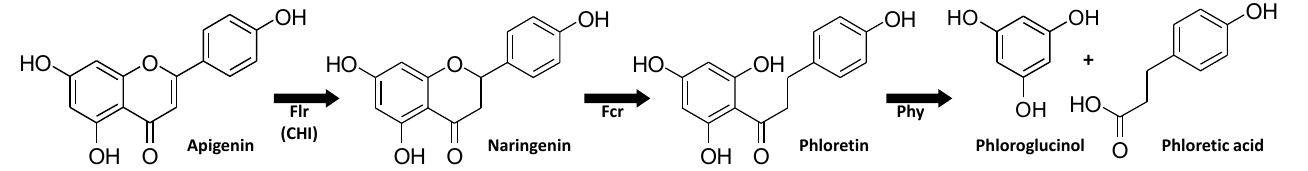
Figure 6. Reductive degradation of flavonoids depictured with apigenin as a flavone example. The BLAST analysis with the characterized flavanone- and flavanonol-cleaving reduc- The very recently characterized Flrs from Flavonifractor plautii and Clostridium ljung- tase (Fcr) from Eubacterium ramulus resulted in hits identified in F. plautii MAGs (523 overall dahlii [50] resulted in a large number of hits in F. plautii and Clostridoides difficile MAGs occurrences, Supplementary Excel File), while E. ramulus MAGs revealed a lower number (the latter interestingly with a higher PID to the sequence of F. plautii than to the sequence of 188 occurrences. Similar to the situation with Flr, several E. ramulus genomes contained of C. ljungdahlii ), and, with a lower PID, in MAGs of the Olsenella, Eubacterium and Fuso- two fcr genes, one of which had a higher PID to the F. plautii gene, which might reflect a bacterium species (Figure 7). Most of the F. plautii MAGs (and also the strain type DSM different substrate spectrum of the encoded Fcrs. Besides F. plautii and E. ramulus , MAGs 6740) harbor two copies of the flr gene, with one of them more closely related (PID of ~ 60) assigned to Anaerostipes hadrus frequently (138 MAGs) encoded an Fcr-like enzyme with to that of Clostridium ljungdahlii than to the “main” Flr of F. plautii . This second putative approximately 85% identity to Fcr from E. ramulus . Besides these three main species, a Flr of F. plautii did not show any apigenin-reducing activity [50], but might reduce other number of MAGs from Clostridium boltae encoded a putative Fcr with a PID of approxi- flavonoid classes, which were not tested in the corresponding study. mately 42 to the Fcr from F. plautii . Most hits to Fcr (several hundred up to nearly 1000) showed around 35 PID (Figure 8) and frequently occurred, in particular, in Faecalicatena spp. Whether these putative enzymes have a similar function and whether Faecalicatena and other species contribute to flavonoid degradation warrants further